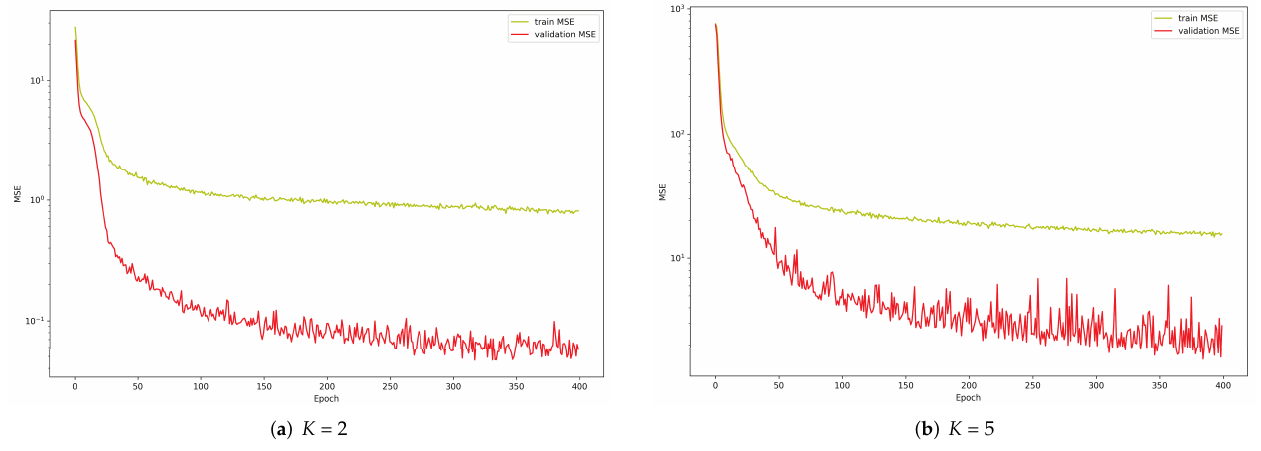
Figure 4. Learning curve of the proposed scheme for the downlink with v = 160